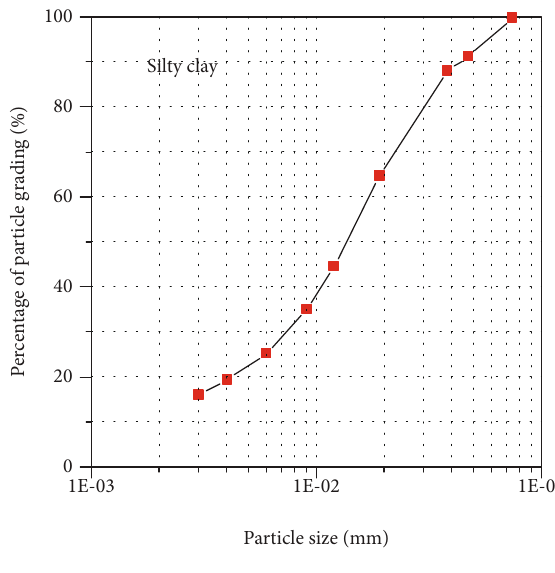
Figure 3: Particle analysis curve of silty clay.